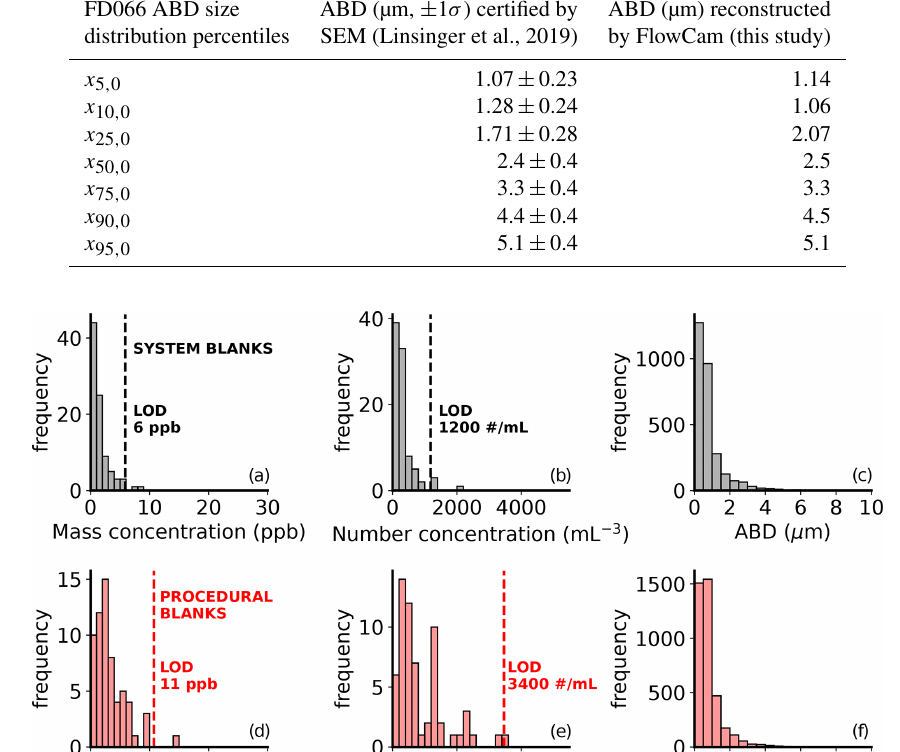
Table 2. Comparison between the FD066 ABD size distributions certified by scanning electron microscopy (SEM; Linsinger et al., 2019) and calculated using the FlowCam (this study).